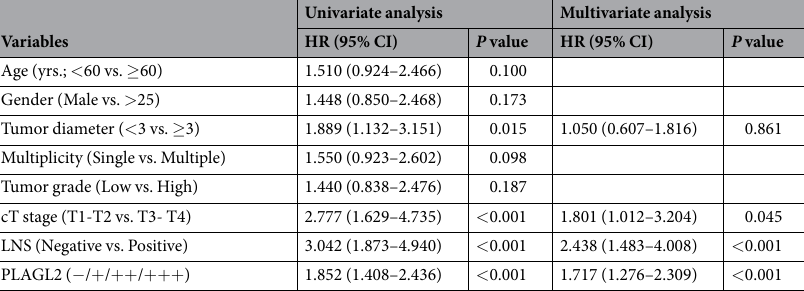
Table 7. Univariate and multivariate Cox proportional hazards analyses for the five-year OS.